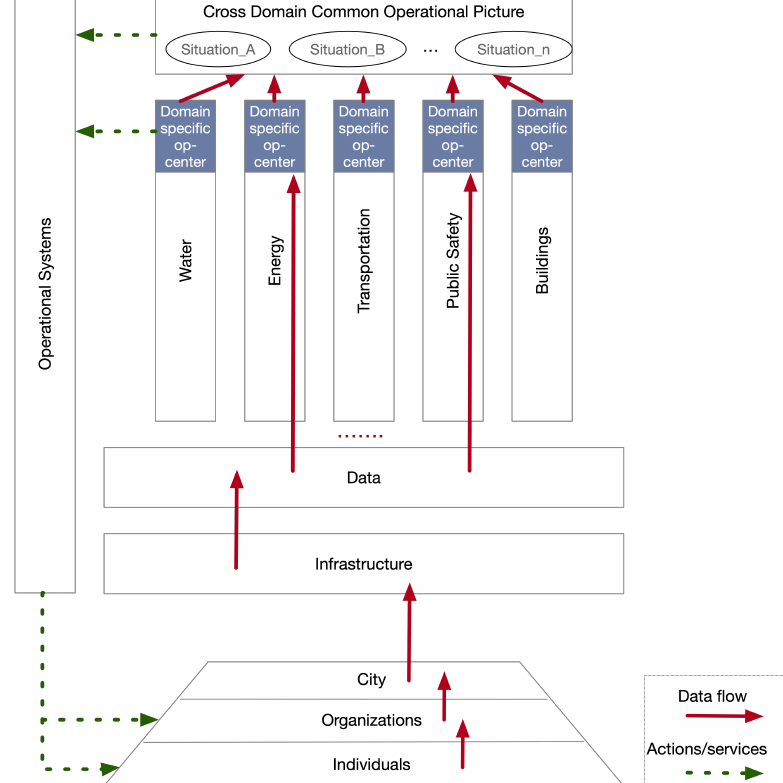
Figure 1. Smart City Service System (SCSS): A conceptual